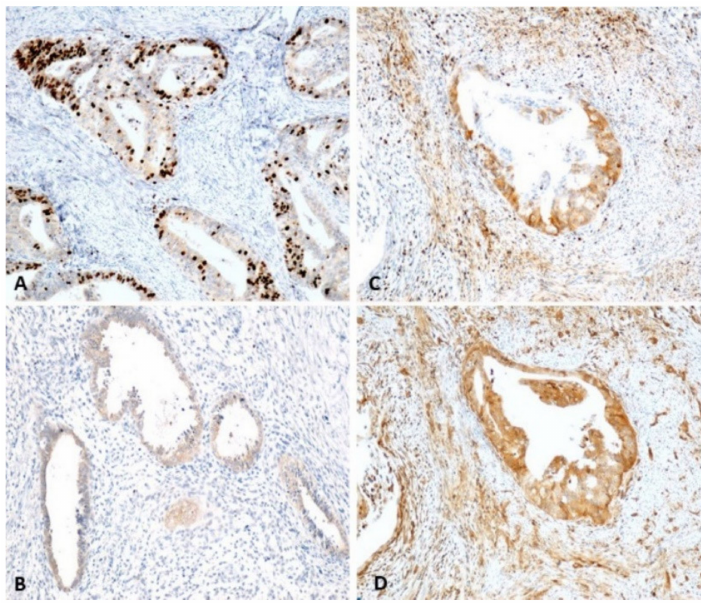
Figure 6. ( A – D )—Proliferative cellularity and tumor proteins in ectopic foci of